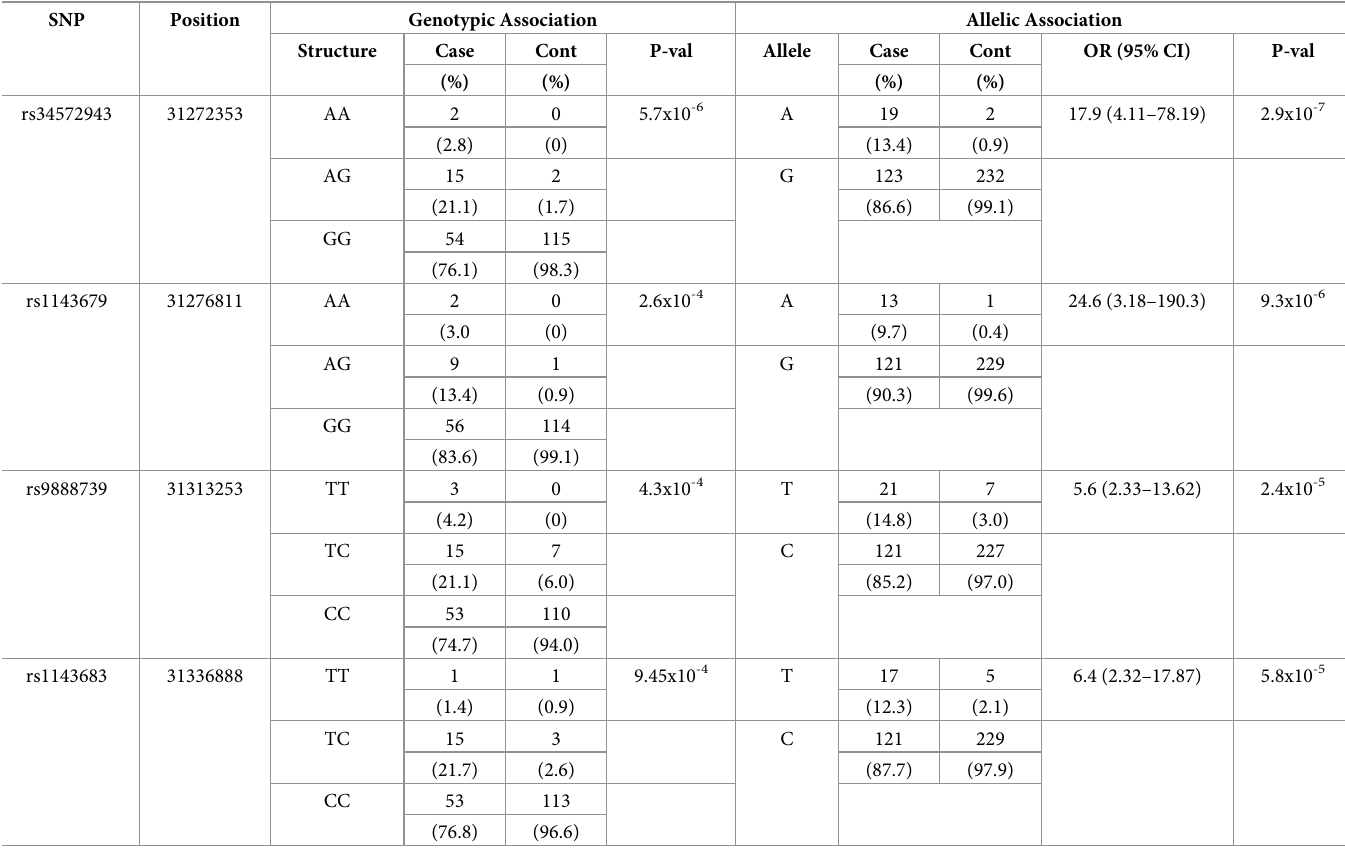
Table 2. Genotypic and allelic frequencies of the ITGAM polymorphisms and association analysis in patients with SLE and controls from Yucata´n. SNP